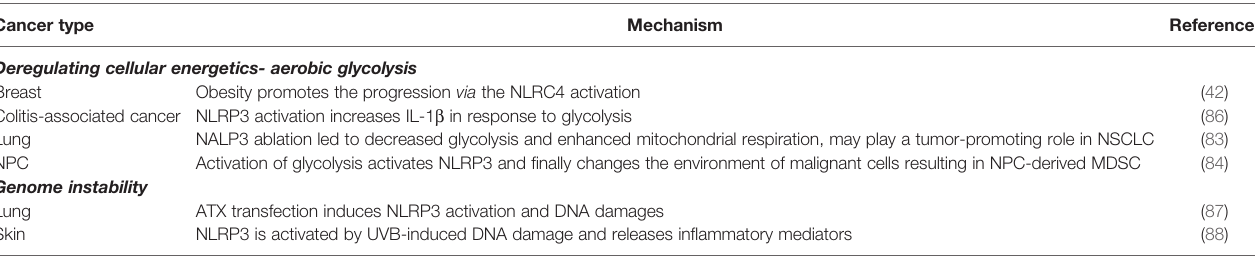
TABLE 3 | Metabolism- and genome instability-associated cancer